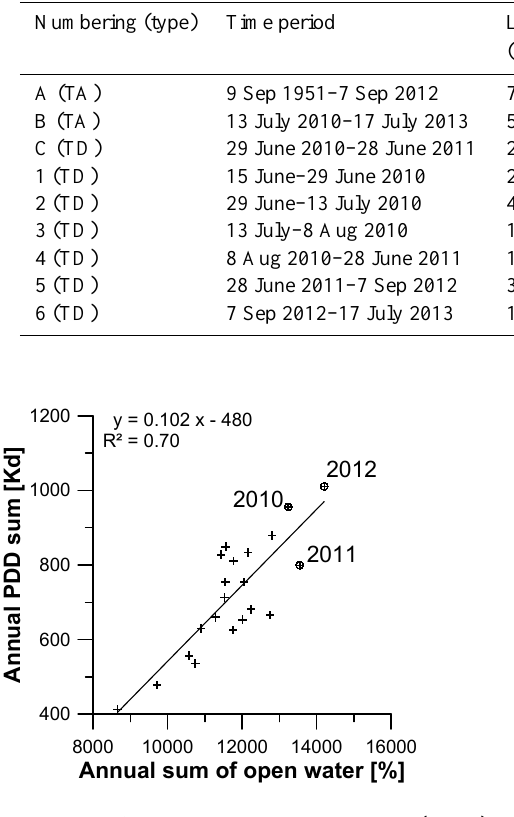
Figure 13. Open water fraction and positive degree-days (PDDs) as annual sums for the reference period of both records